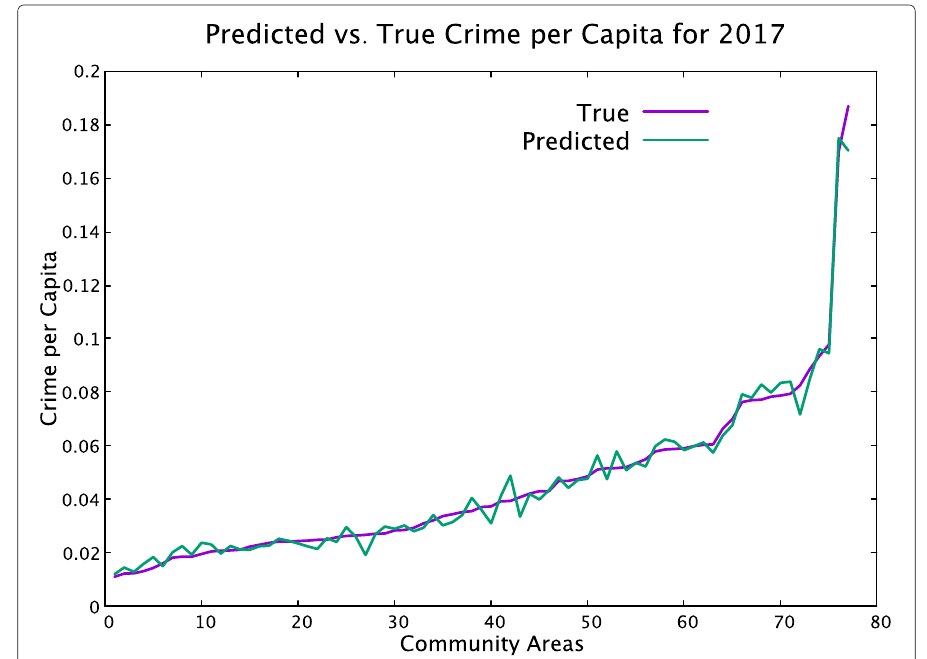
Fig. 5 Forecasting the crime per capita rate for the upcoming year. The predictions are plotted versus true per capita crime rate for year 2017 using features F 4 1 , F 5 1 , and F 4 2 , so using two years of data for feature F 4 . On the X-axis, community areas are listed in the increasing order of the crime rate per